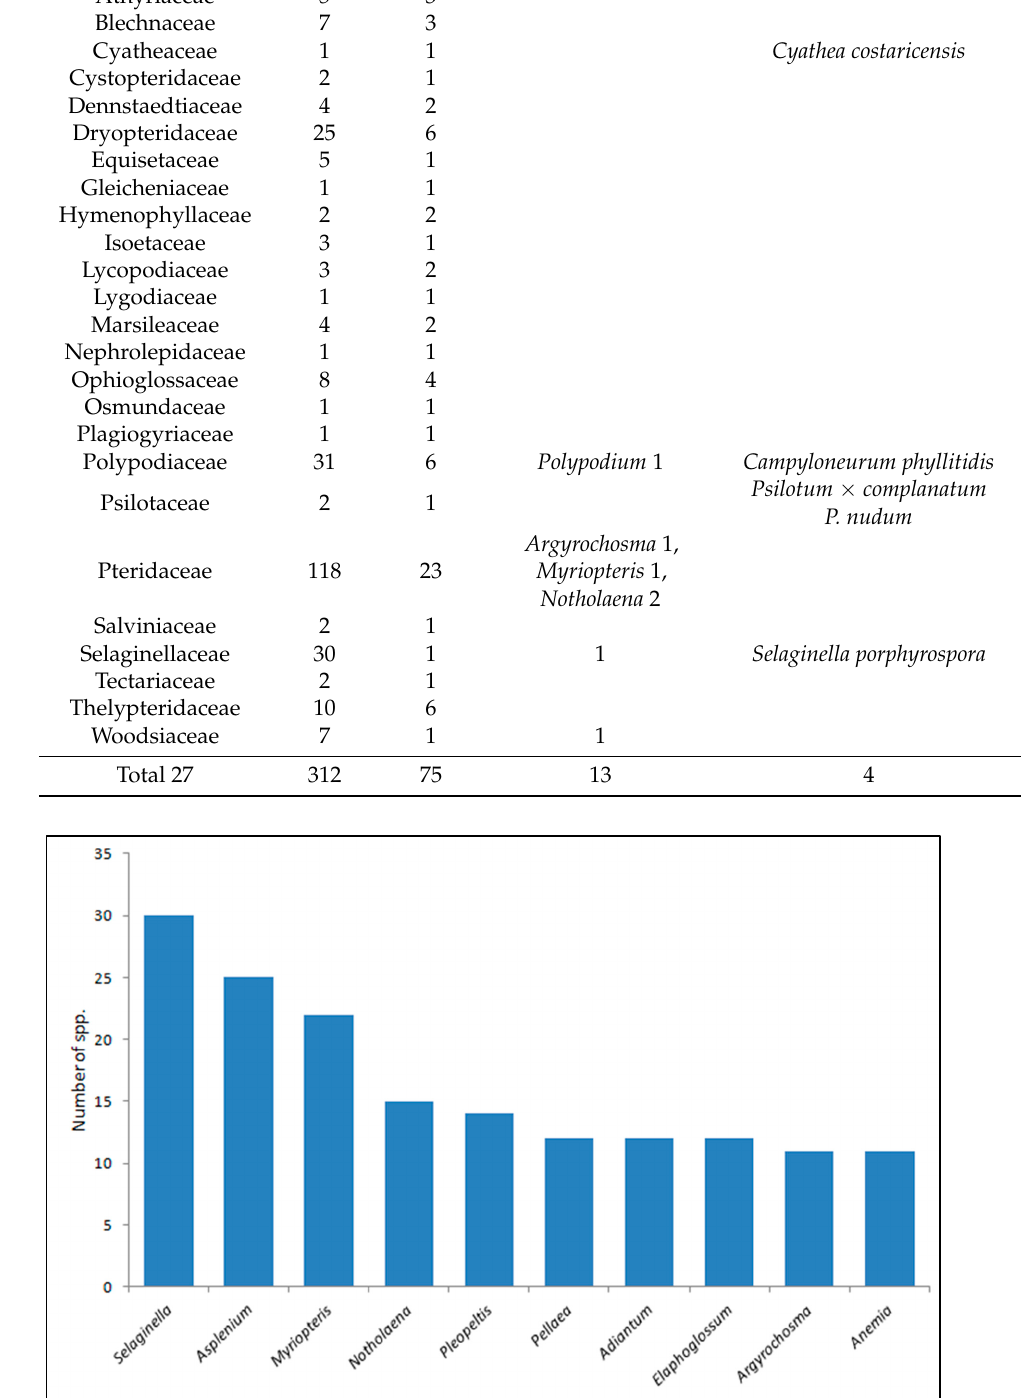
Figure 2. The richest genera (>10 species) in the SMOc.